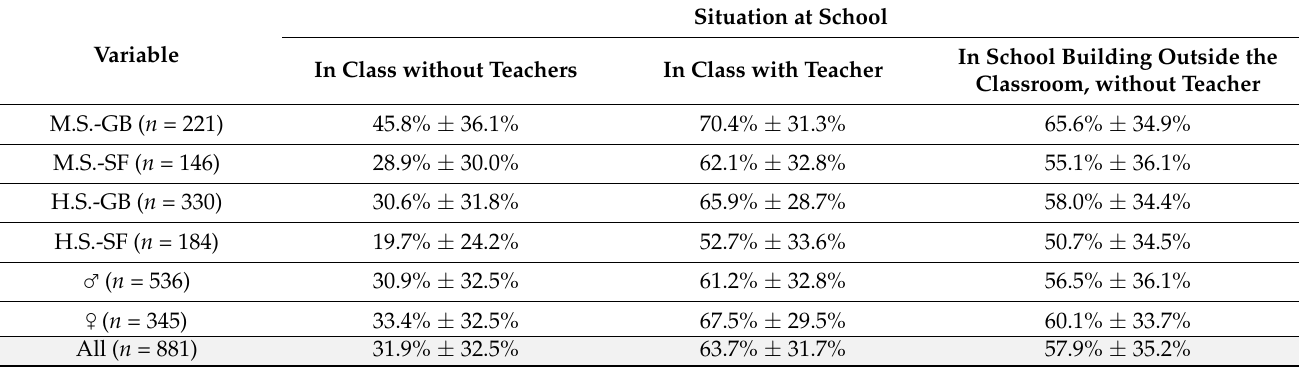
Table 1. Detailed percentages of self-estimated correct mask wearing in different situations in the